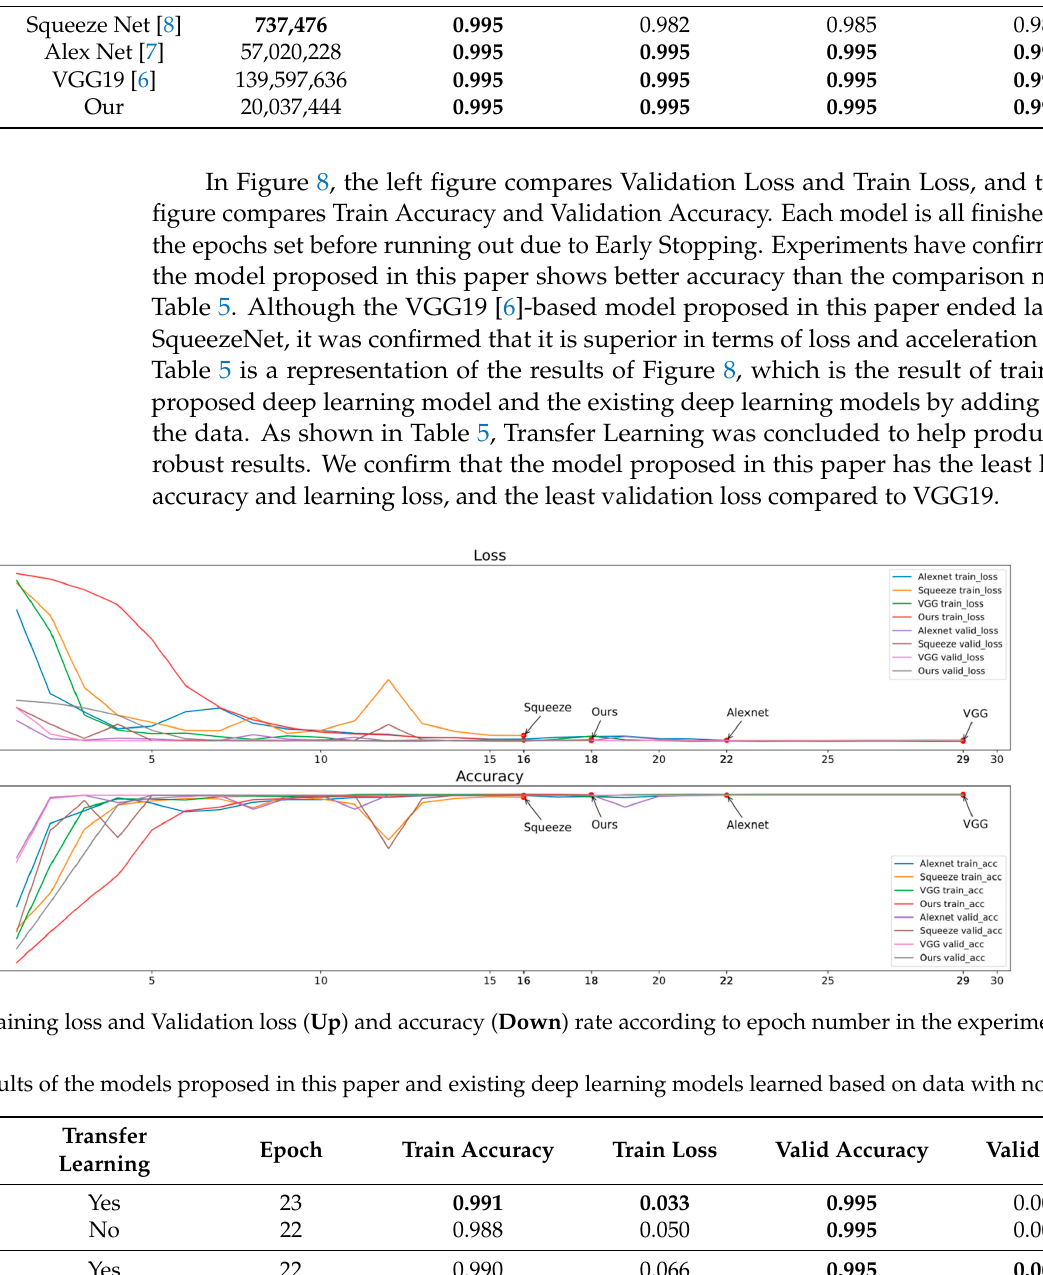
Table 4. Train noise-added data to compare test results with existing deep learning models.